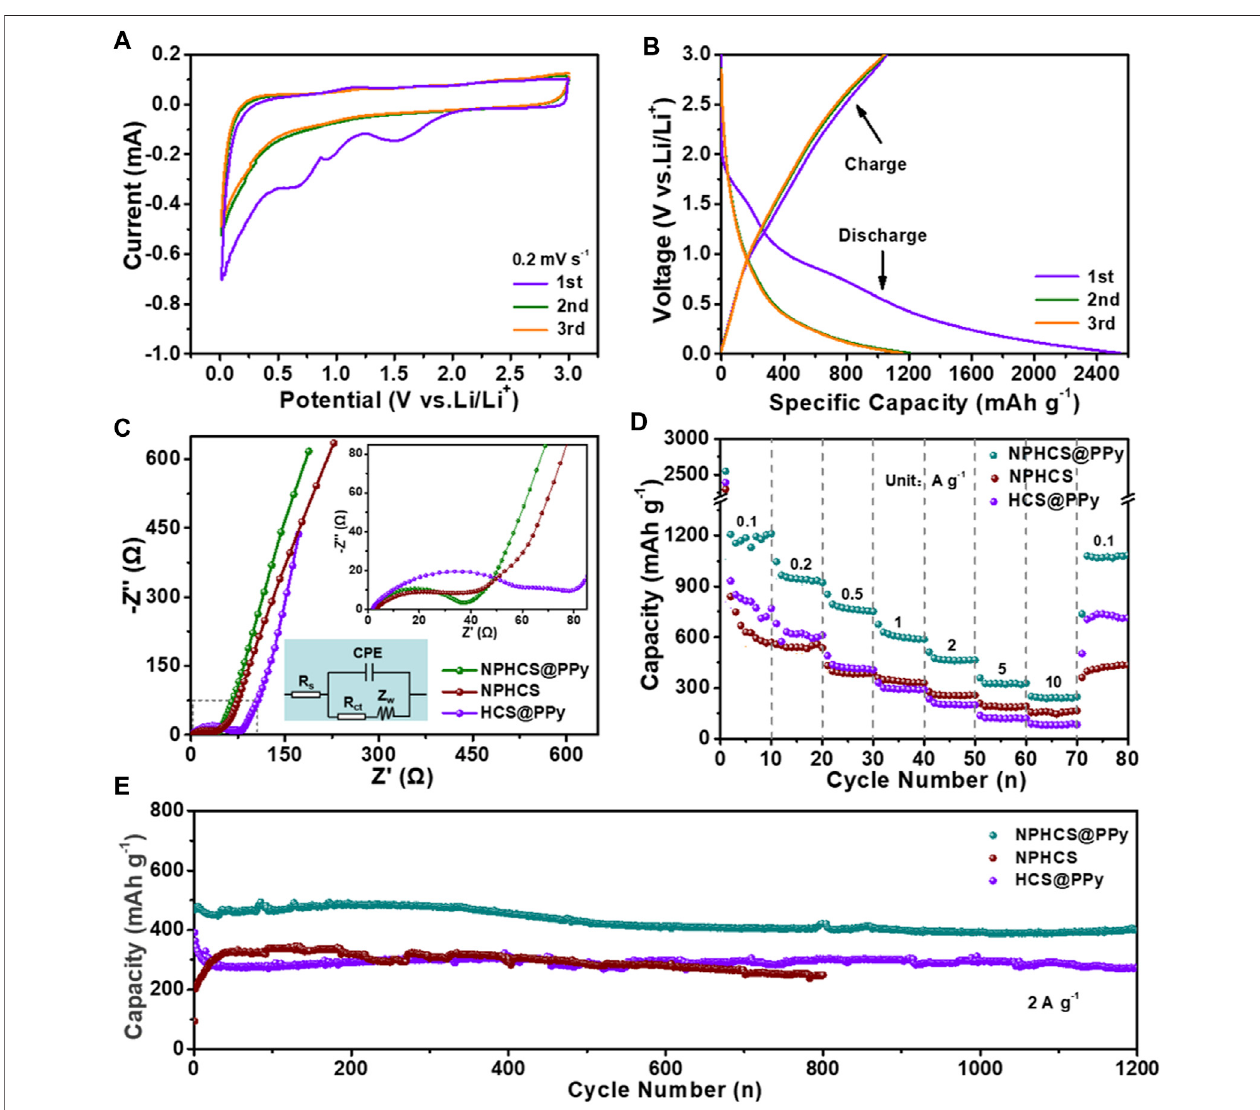
FIGURE 3 | (A) CV curves of NPHCS@PPy anode for the fi rst three cycles at a scan rate of 0.2 mV s − 1 (B) GCD pro fi les of NPHCS@PPy anode for the fi rst three cycles at acurrent density of 0.1 A g − 1 (C) Nyquistplots withthe insert ofequivalent circuitmodel (D) rate performancesand (E) cycling performancesofNPHCS@PPy, NPHCS, and